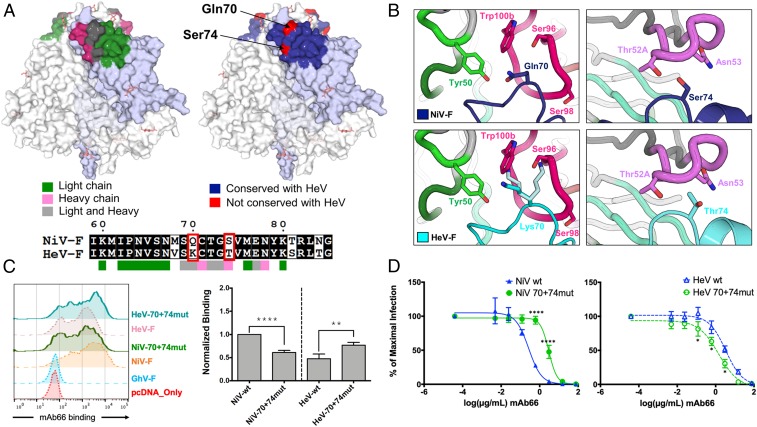
Differences between NiV-F and HeV-F at the Fab66 footprint. (A) Surface view of the NiV-F is shown in white, with 1 protomer shaded in light blue for clarity. (Upper Left) The residues in the binding interface are colored according to the Fab66 chain involved in the contact, with residues contacted by the light chain shown as green, heavy-chain contacts shown as pink, and residues contacted by both chains shown in gray. (Lower) A sequence alignment between NiV-F (Malaysia, AAV80428.1) and HeV-F (AEB21197.1), was generated by Multalin (81) and plotted by ESPript (82). Residues involved in the Fab66 interface are noted with colored boxes below the alignment. Residues that differ between NiV-F and HeV-F are outlined by a red box. (Upper Right) The entire binding footprint of Fab66 is shown as blue. The residues that differ between NiV-F and HeV-F within the epitope, Gln70 and Ser74, are shown in red and labeled. (B) To model Fab66 binding at residues 70 and 74 on NiV-F (Upper) and HeV-F (Lower), the HeV-F structure [PDB ID code 5EJB (46), cyan cartoon] was aligned to NiV-F (dark blue cartoon). (Upper Left) Representation of Gln70 on NiV-F (dark blue), which forms hydrogen bond contacts with Tyr50 (CDR L2, light green) and Ser98 (CDR H3, hot pink). (Upper Right) Representation of Ser74 on NiV-F (dark blue), which forms hydrogen bond contacts with residues Thr52A and Asn53 (CDR H2, pink) of Fab66. (Lower Right) The threonine at position 74 in HeV-F (cyan) does not show obvious clashes with CDR H2 of Fab66. (Lower Left) The lysine substitution in HeV at position 70 shows the lysine side chain as modeled in the crystal structure [PDB ID code 5EJB (46), cyan], as well as 2 rotamers (light cyan) that clash with residues Ser96 and Trp100B in CDR H3 (hot pink) of Fab66. (C) Representative FACS histogram plots showing binding of mAb66 to WT NiV-F, HeV-F and the indicated reciprocal double mutant (70+74mut), as described in the text (Left). Normalized mAb66 binding were analyzed and presented as bar graphs (Right). The experiment was performed and analyzed as in Fig. 3C (**P < 0.01; ****P < 0.0001). (D) mAb66 neutralization curves of NiVpp and HeVpp infection on permissive U87 glioblastoma cells were generated as detailed in Fig. 3D, with the exception of the different HNV-F mutants used here. Each neutralization curve was performed in biological triplicates comprising of technical duplicates per biological replicate. Data was analyzed as in Fig. 3D (*P < 0.05; ****P < 0.0001).